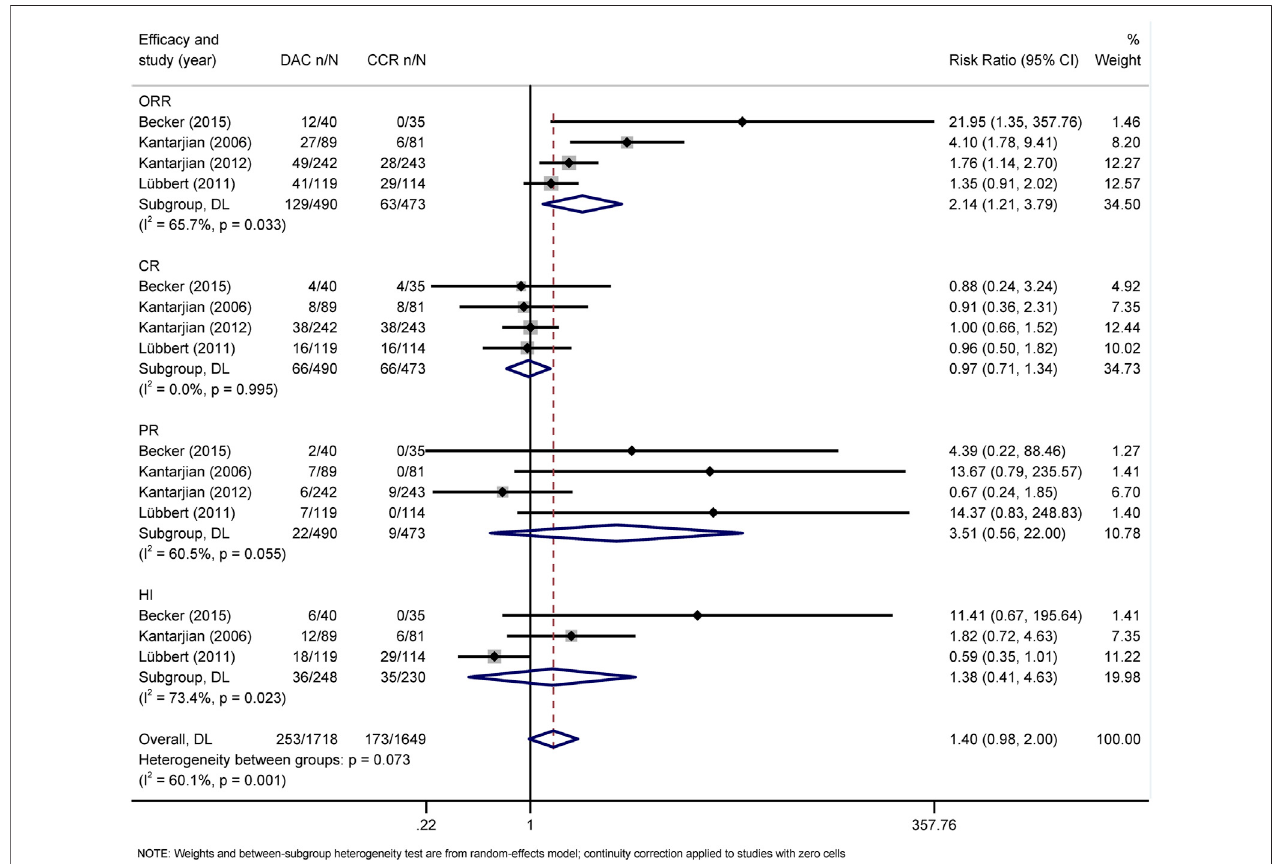
FIGURE 5 | Forest plot of ef fi cacy of decitabine vs. conventional care regimens (direct evidence-RR).